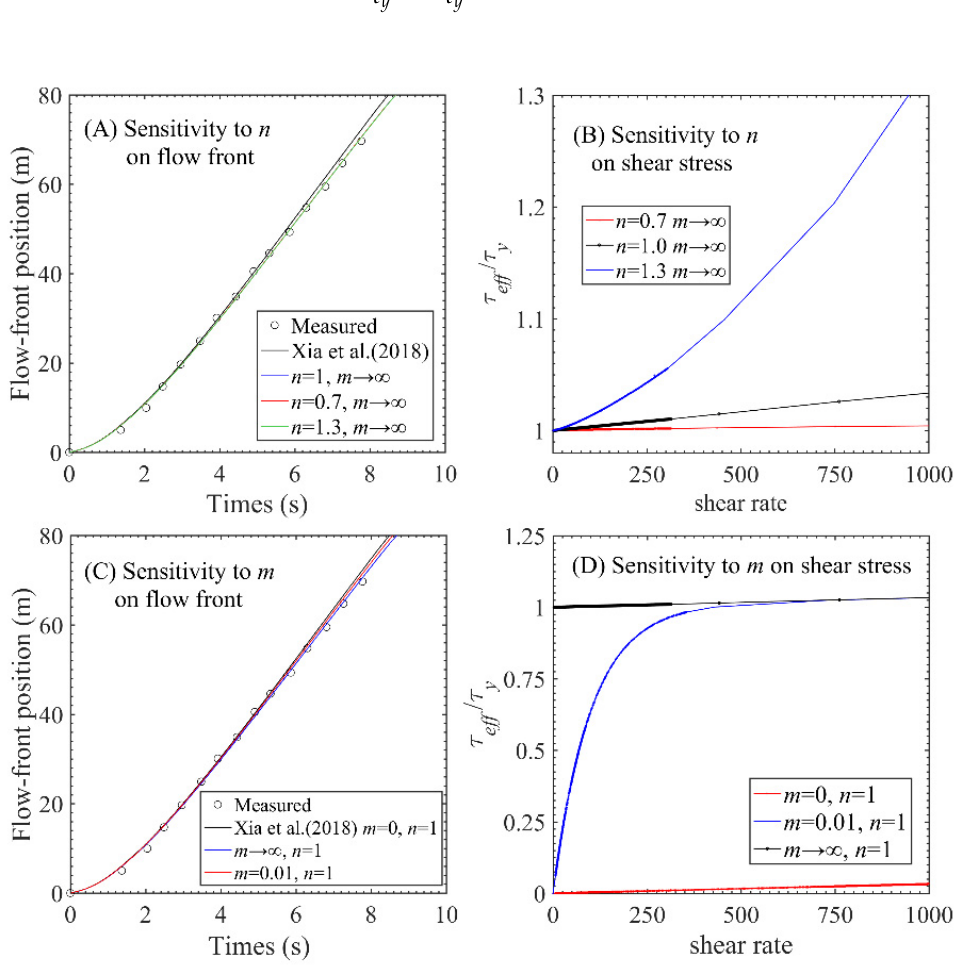
Figure 3. Sensitivity to coefficients n and m . ( A ) Flow front sensitivity to n ; ( B ) shear stress sensitivity to n ; ( C ) flow front sensitivity to m ; ( D ) shear stress sensitivity to m . Table 1. norm of the HBP model with tuned n and m.